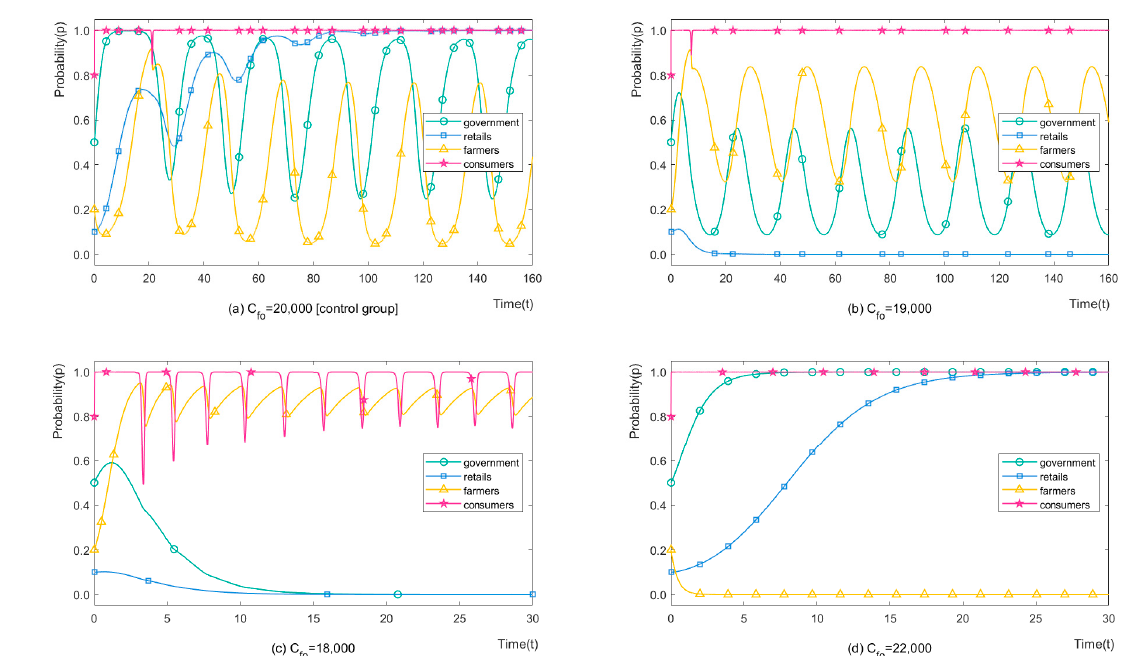
Figure 5. The strategy evolution process of stakeholders with different C fo .